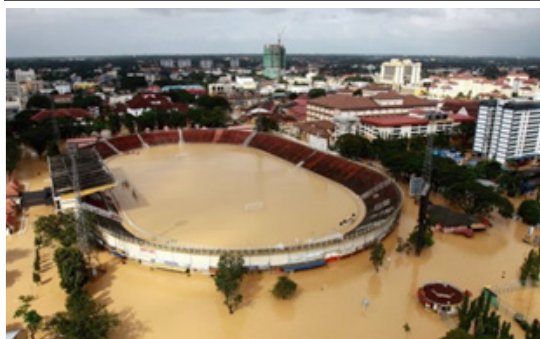
Figure 1. Sultan Muhammad V Stadium in Kota Bharu, the capi- tal of the state of Kelantan, Malaysia, after